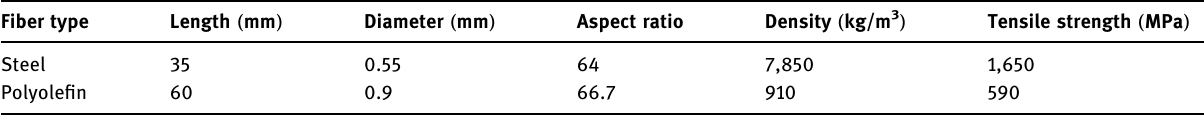
Table 1: Properties of fi bers Fiber type